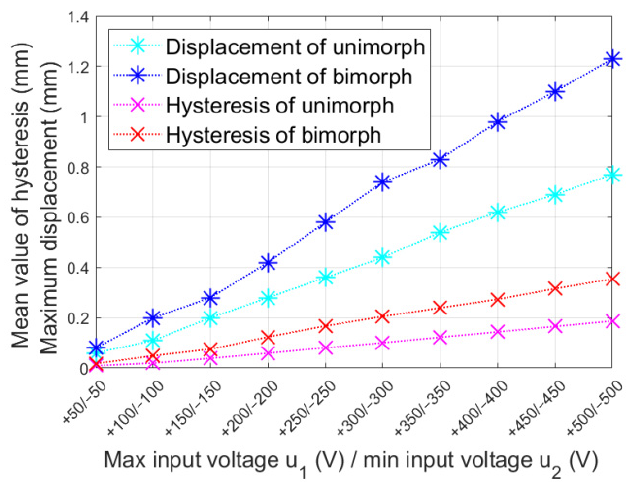
Figure 11. Maximum displacements of the actuator beam tip and mean hysteresis values. Increases in maximum displacements of the actuator beam tip, maximum hystereses, and mean values of hysteresis were determined for the unimorph and bimorph. Compar- ison of these increases, expressed as a percentage, is shown in Figure 12.